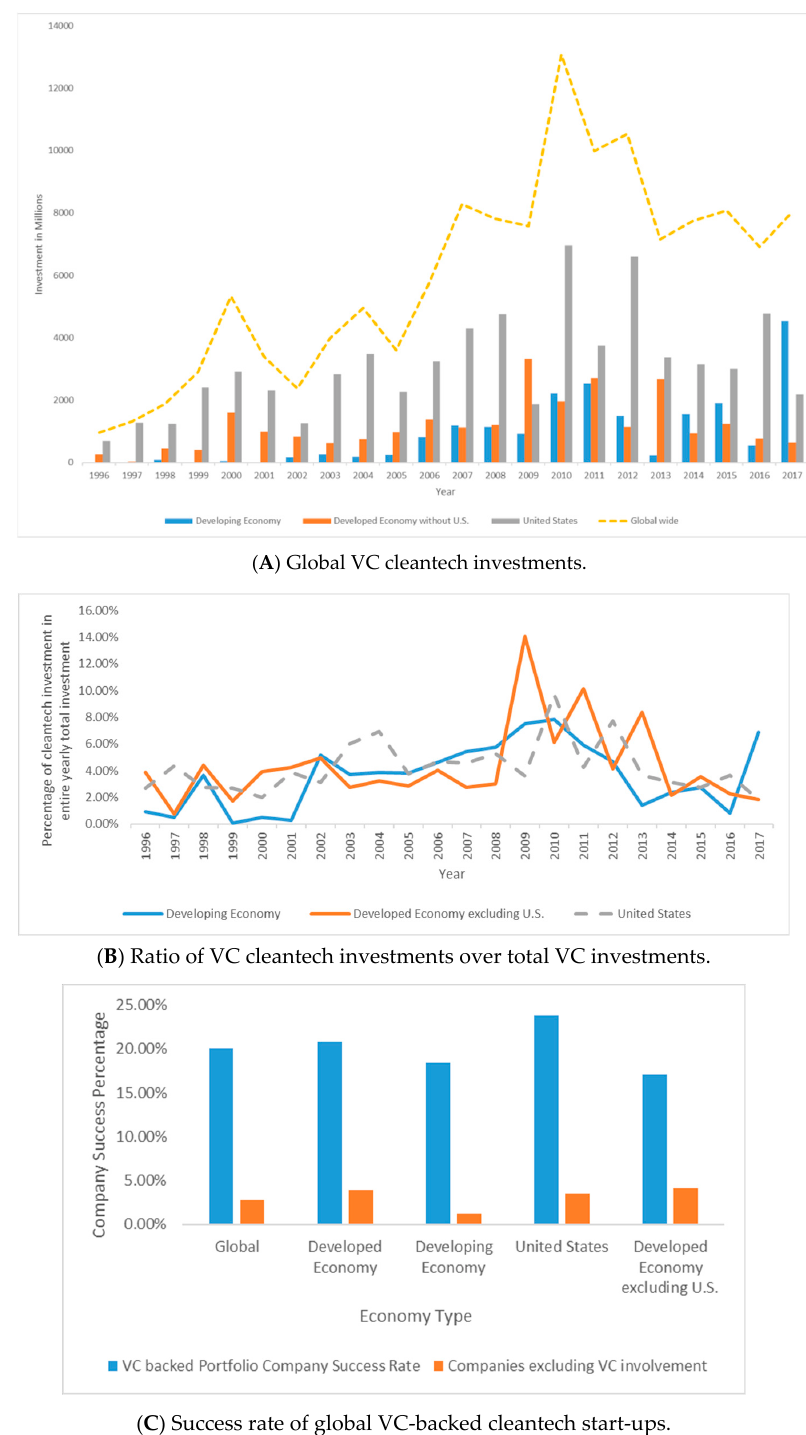
Figure 2. Global venture capital (VC) cleantech investments.